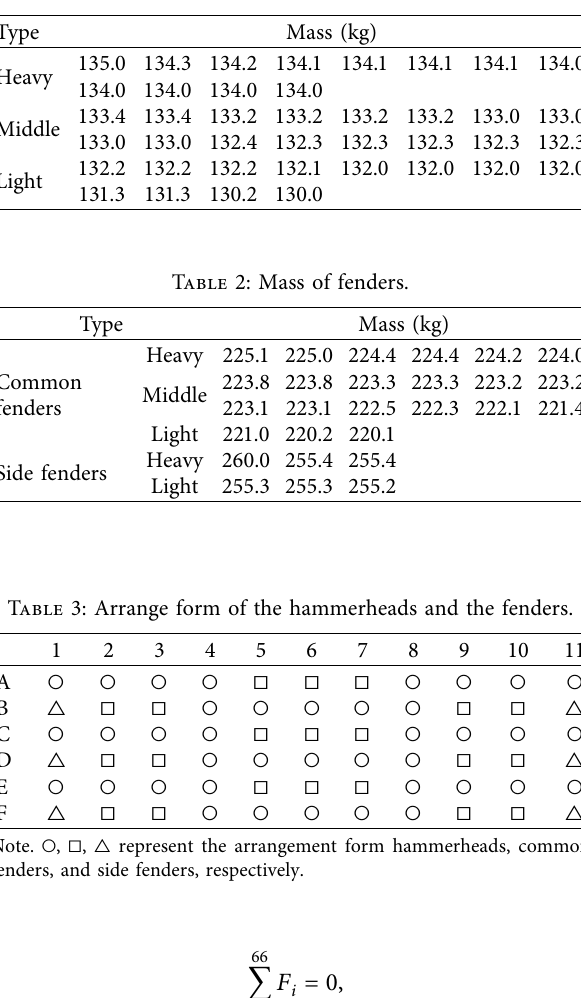
Figure 1: The model of SMS. (a) Physical model of SMS (PFY2026); (b) three-dimensional model of SMS. Table 1: Mass of hammerheads.